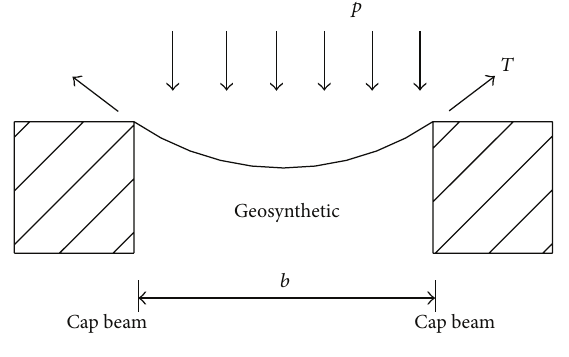
Figure 2: Sketch of 2D